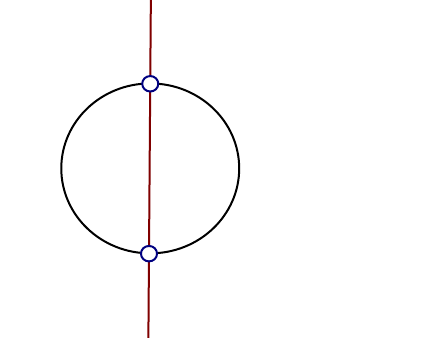
FIG. 9. A reflection acting on a circle. The reflection axis is shown in red, and the fixed points are marked with blue circles. SPT phases of this symmetry setup are classified by a Z 2 charge at each fixed point. There are more phases in this geometry than on a line with a single reflection